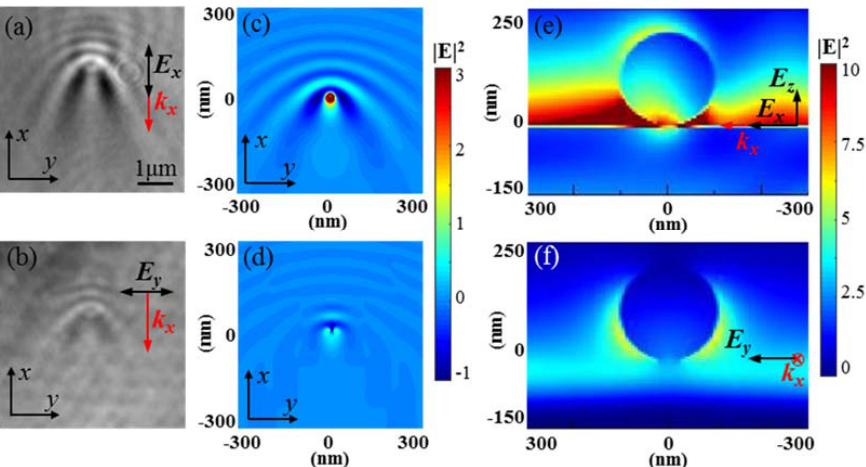
Figure 5. The TIR ‐ based leakage radiation imaging of single 200 nm PS nanospheres under ( a ) TM illumination and ( b ) TE illumination. The simulated near ‐ field electric field intensity of 200 nm PS nanospheres at z = 5 nm under ( c ) TM illumination and ( d ) TE illumination. The simulated near ‐ field electric field intensity of 200 nm PS nanospheres at ( e ) y = 0 nm under TM illumination, and ( f ) x = 0 nm under TE illumination. The k x indicates the propagation direction of the evanescent